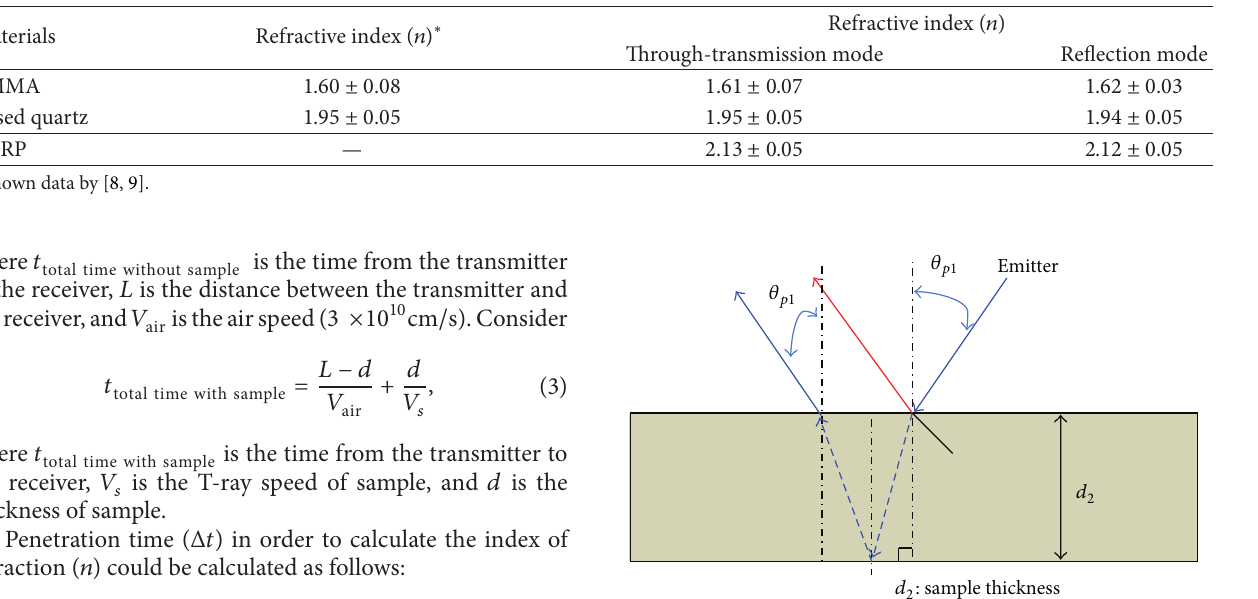
Table 1: Average THz refractive indices of the material studied.